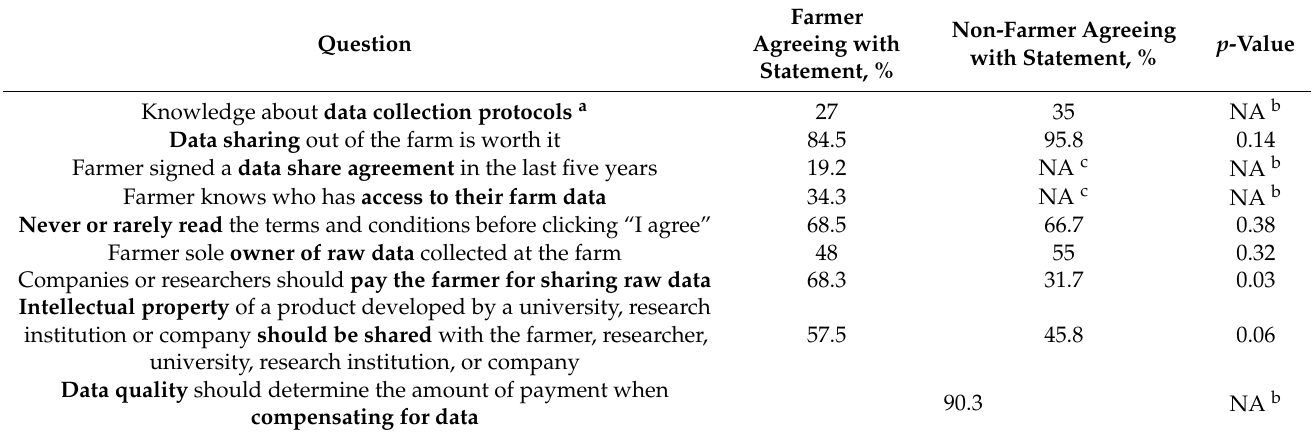
Table 1. Response summary of the data collection protocols, data sharing, data ownership, and data